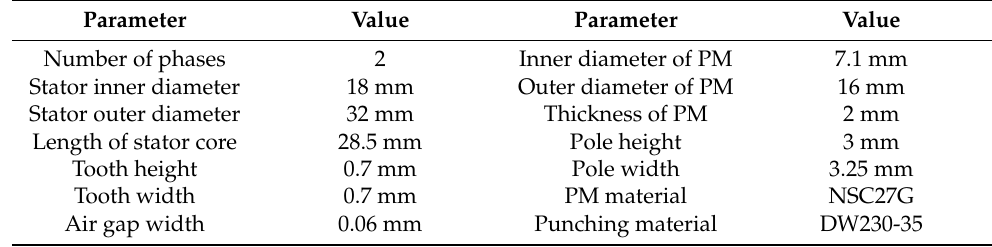
Table 1. Dual- redundancy HSM design